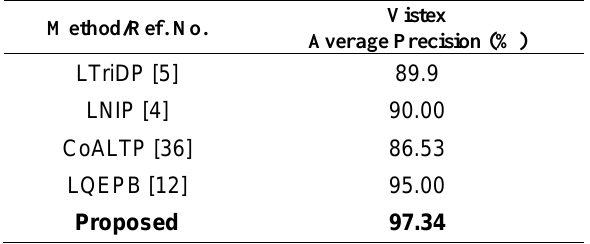
Table 5. Comparison of the proposed system with the prominent state-of-the-art techniques